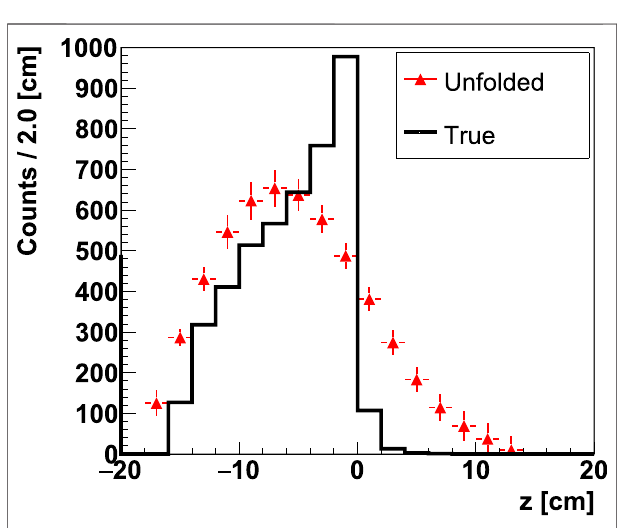
FIGURE 12 | Unfolded distribution of the reconstructed prompt photons emission along the beam axis (z coordinate) (red triangles) obtained from 10 11 160 MeV protons impinging on a PMMA target. The distribution of the actual points at production is superimposed (black line). The errors on the unfolded spectrum are only statistical, mainly due to the unfolding procedure.